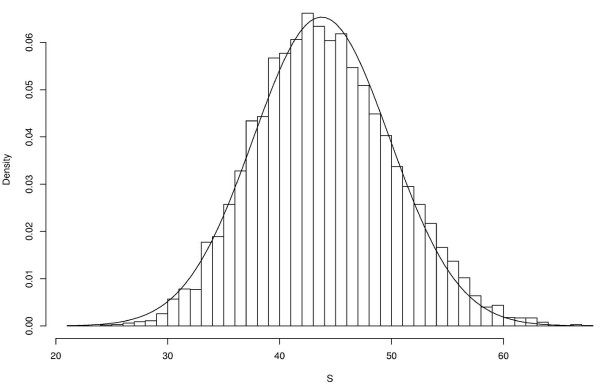
Empirical and theoretical distributions of S^
 MathType@MTEF@5@5@+=feaafiart1ev1aaatCvAUfKttLearuWrP9MDH5MBPbIqV92AaeXatLxBI9gBaebbnrfifHhDYfgasaacH8akY=wiFfYdH8Gipec8Eeeu0xXdbba9frFj0=OqFfea0dXdd9vqai=hGuQ8kuc9pgc9s8qqaq=dirpe0xb9q8qiLsFr0=vr0=vr0dc8meaabaqaciaacaGaaeqabaqabeGadaaakeaacuWGtbWugaqcaaaa@2DEB@. A sample of size 10 000 have been used to get the empirical distribution. The solid line represents the density of N
 MathType@MTEF@5@5@+=feaafiart1ev1aaatCvAUfKttLearuWrP9MDH5MBPbIqV92AaeXatLxBI9gBamrtHrhAL1wy0L2yHvtyaeHbnfgDOvwBHrxAJfwnaebbnrfifHhDYfgasaacH8akY=wiFfYdH8Gipec8Eeeu0xXdbba9frFj0=OqFfea0dXdd9vqai=hGuQ8kuc9pgc9s8qqaq=dirpe0xb9q8qiLsFr0=vr0=vr0dc8meaabaqaciaacaGaaeqabaWaaeGaeaaakeaaimaacqWFneVtaaa@383B@(S, σ2). The adjustment test of Kolmogorov-Smirnov give D = 0.023 which corresponds to a p-value of p = 5.3 × 10-5. Nobs = 1221 and n = ℓ = 10 000.